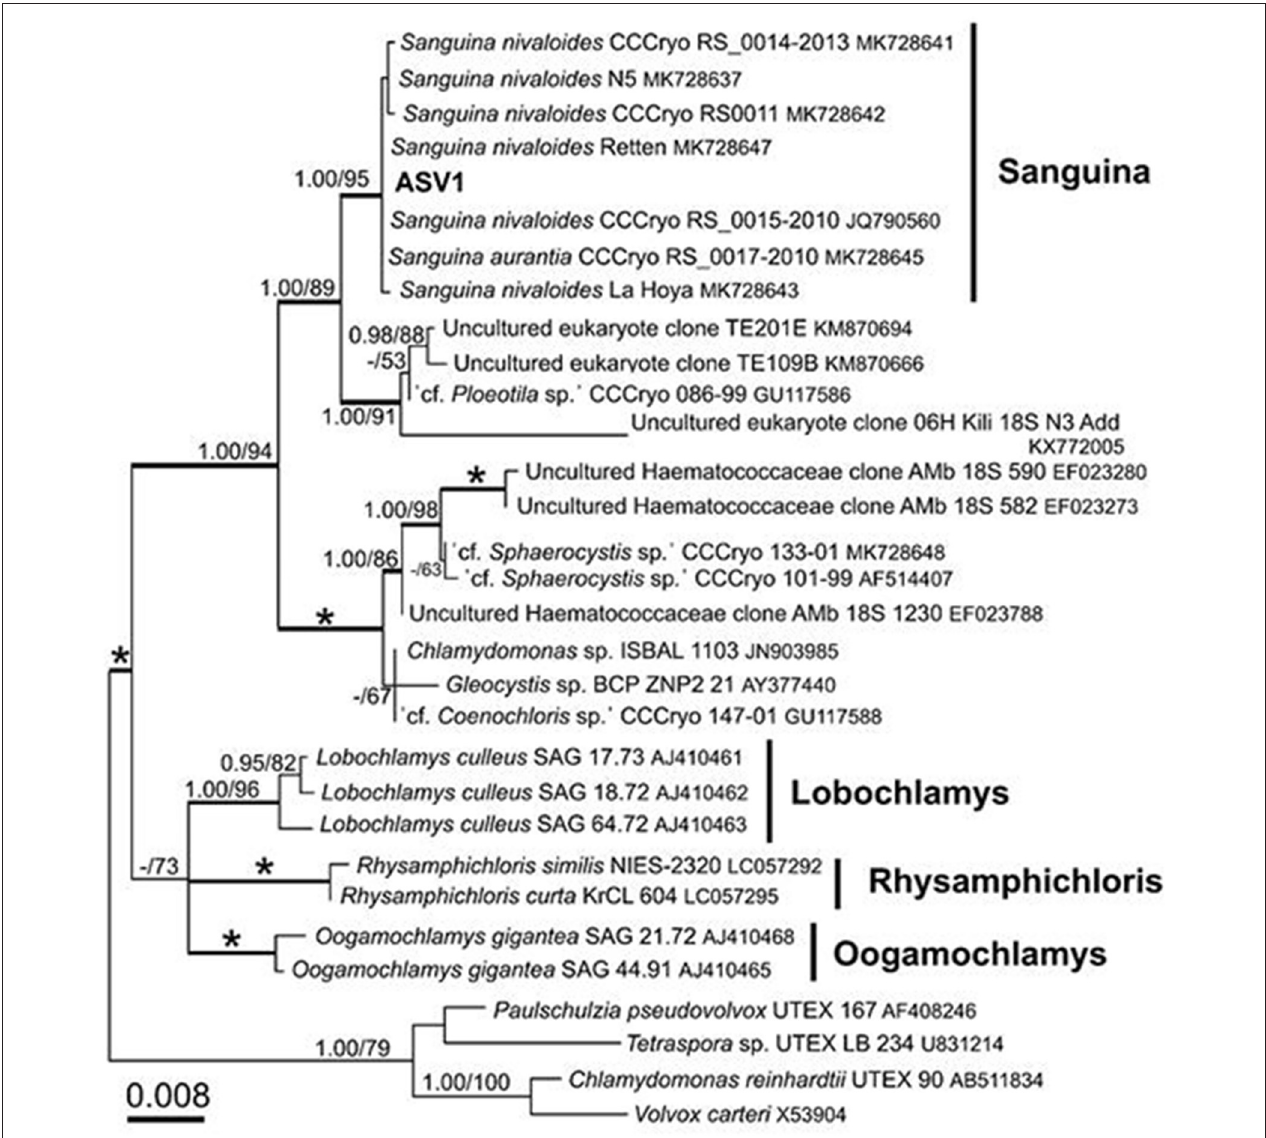
FIGURE 7 | 18S rRNA-gene-based maximum likelihood phylogeny of Sanguina spp. showing phylogenetic position of one of the major ASV reads (ASV1) detected in the red snow samples in Mt. Tateyama, Japan. Posterior probabilities ( ≥ 0.95) and bootstrap values from maximum likelihood analysis ( ≥ 50%) are shown. Full statistical support (1.00/100) is marked with an asterisk. Thick branches represent nodes receiving the highest posterior probability support (1.00). Accession numbers, strain, or field sample codes are indicated after each species